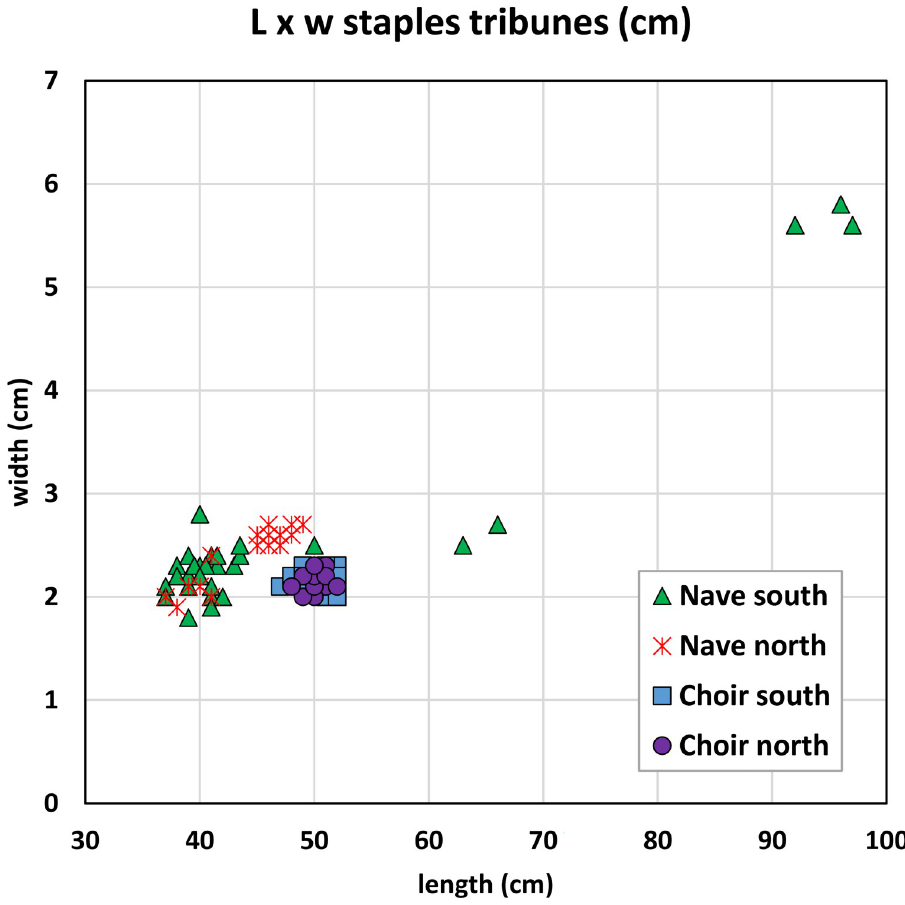
Fig 8. Dimensions of the staples of the